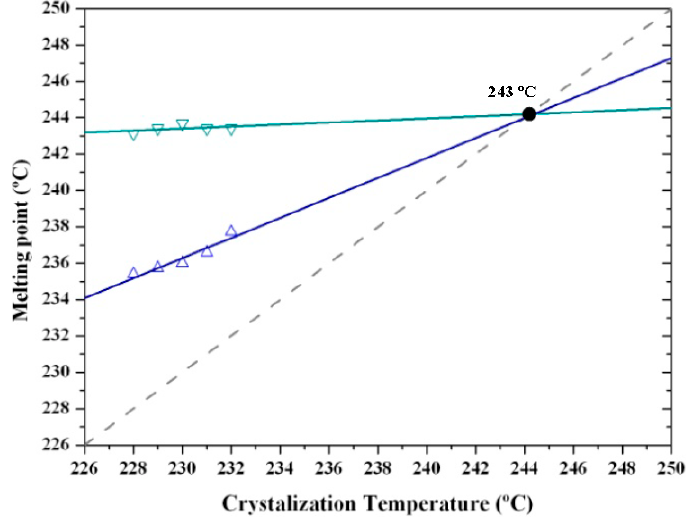
Figure 16. Hoffman–Weeks plot of temperatures corresponding to the observed endothermic Peaks II and III associated with the high temperature Form III versus hot crystallization temperature. An equilibrium melting temperature of 243 °C could be deduced.